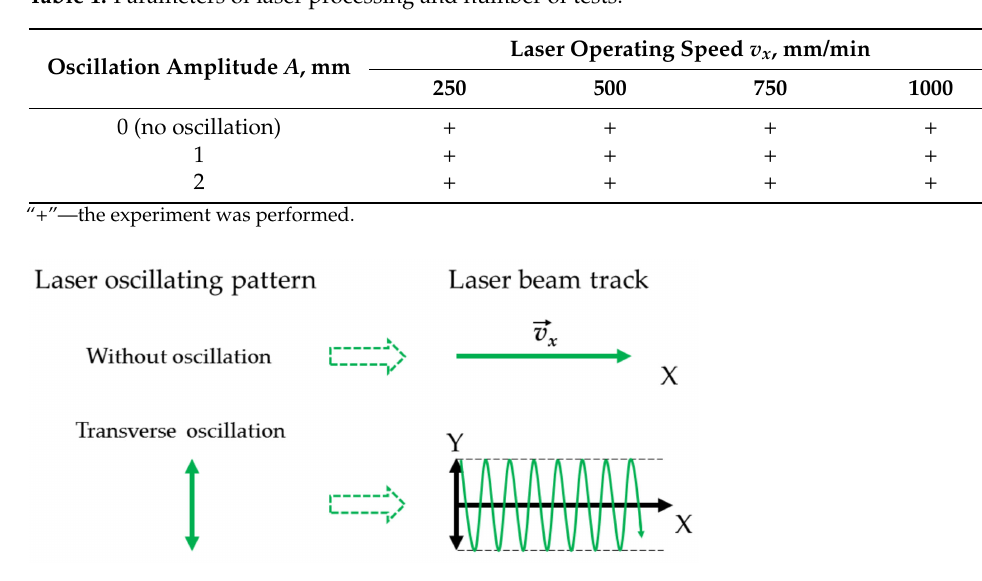
Figure 1. Schematic diagrams of beam oscillating pattern and the resultant track of laser